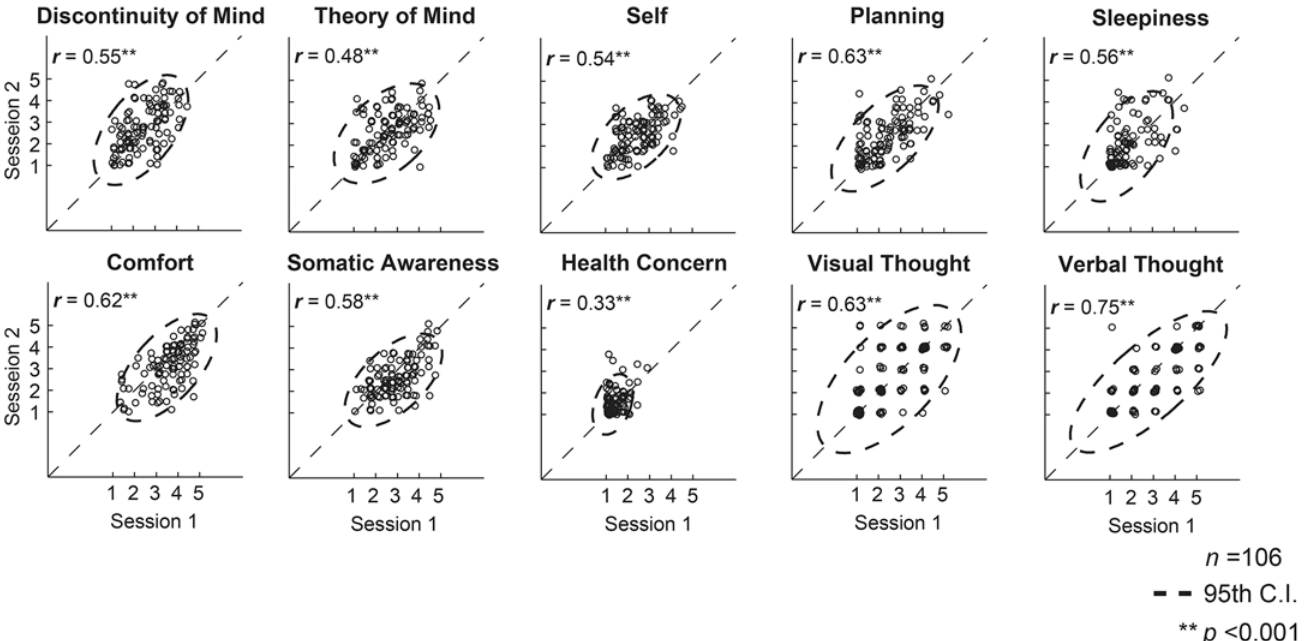
Fig 2. Mind wandering during a resting state primarily varies across subjects. The mind-wandering experiences over two resting-state sessions were strongly and positively correlated (Pearson), yet displayed substantial between-subject variation. To aid visualization, jitter ( M ± SD = 0.1 ± 0.05) was added to the data points; dashed ellipses indicate the 95% confidence limit, statistics describe raw data before adding